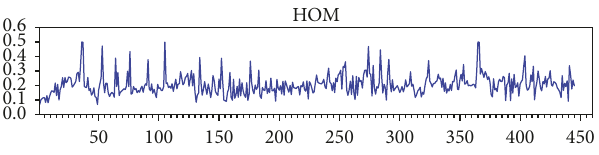
Figure 10: Belief homogeneity evolutions 2012-2013.